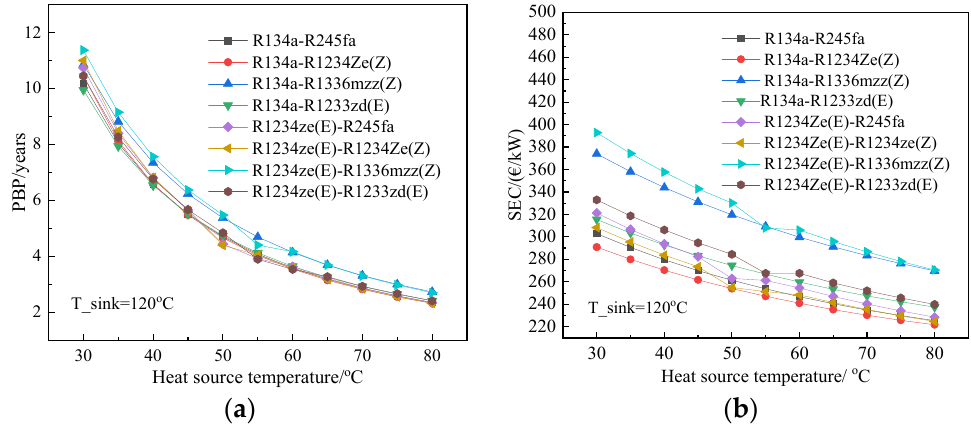
Figure 8. Effects of working fluids on the economic performance. ( a ) PBP change with various working fluids. ( b ) SEC change with various working fluids.